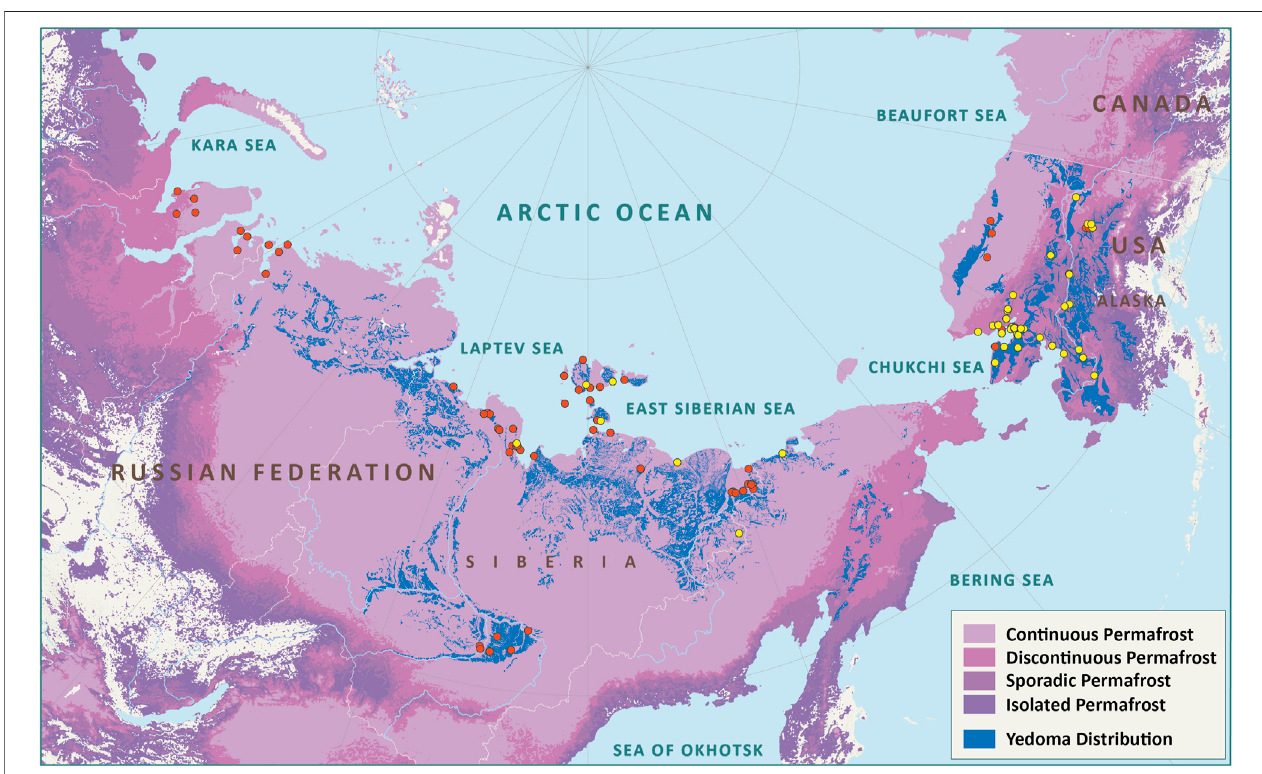
FIGURE 1 | Distribution of Yedoma Research Topic study sites. Red circles — single sites that are subject of the various papers in the Research Topic; Yellow circles — locations of the historical observations according to Shur et al. (Map by Sebastian Laboor, AWI).